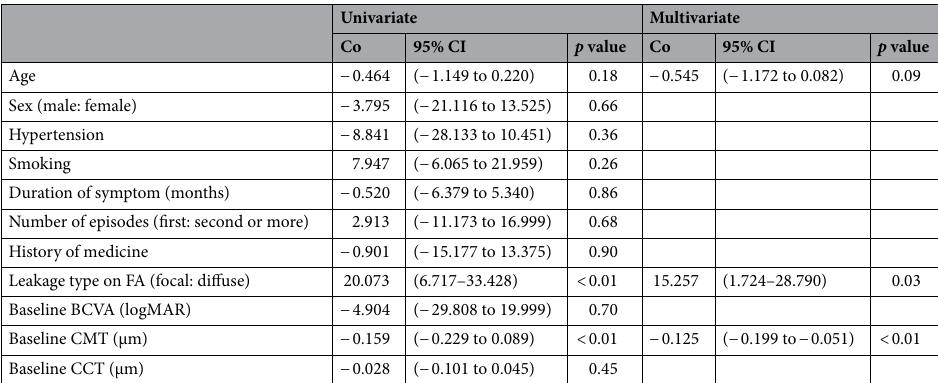
Table 3. Univariate and multivariate analysis of factors associated with the rate of change in central macular thickness at 6 months after selective retina therapy. Co : coefficient; CI : Confidence interval.